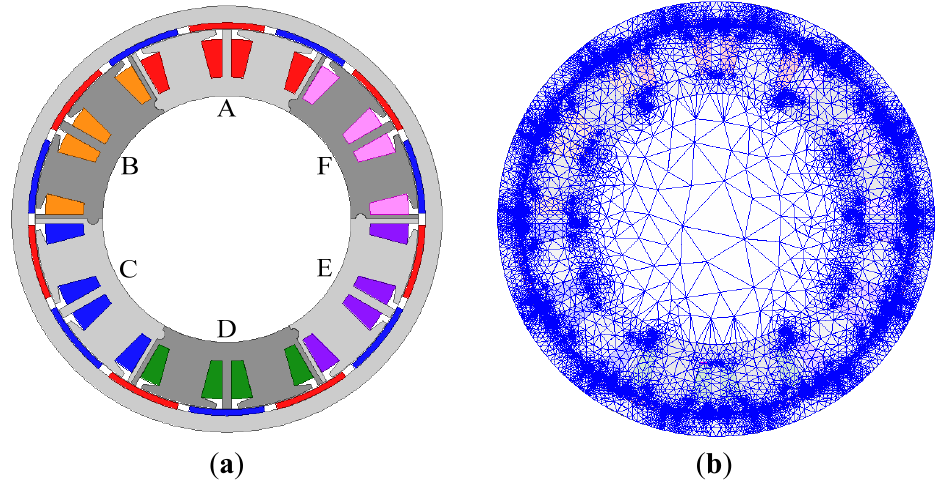
Figure 9. Original finite element model of the outer rotor 24-slot/14-pole scheme: ( a ) model; and ( b ) mesh